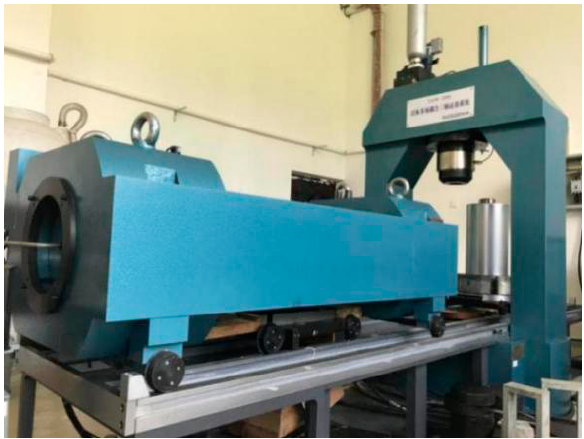
Figure 4. TAJW–2000 rock mass multi-field coupling triaxial test system.